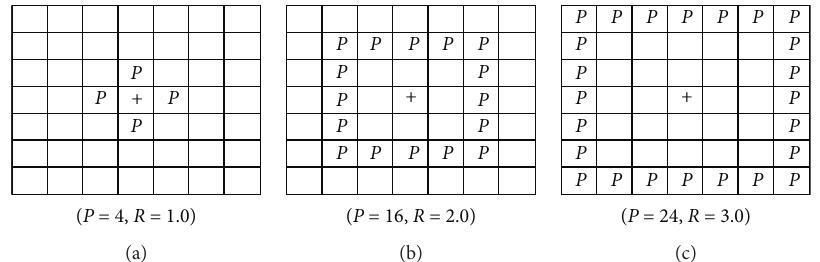
Figure 3: Squared symmetric neighborhood for different ( P , R ). P represents neighbors and R represents the spatial resolution. Multi- resolution analysis is done by choosing P as 4, 16, and 24 and R as 1.0, 2.0, and